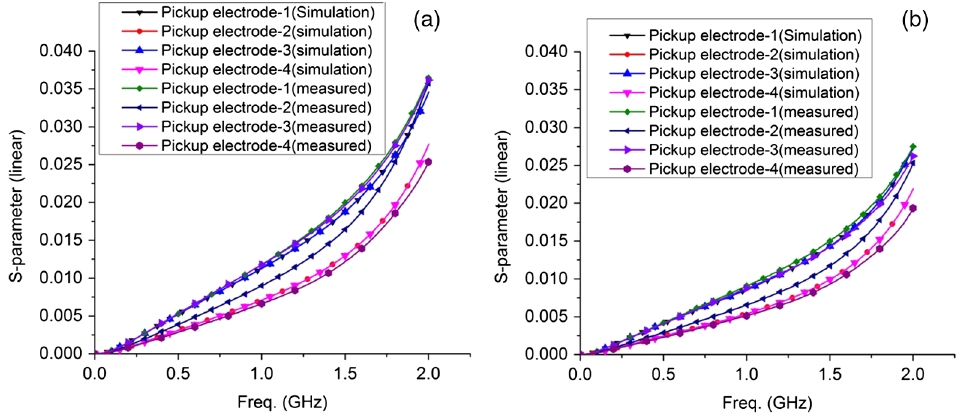
FIG. 17. Comparison of S-parameters of IDBPI obtained through simulation with measured data for different electrodes. (a) 1.5 mm wire diameter and (b) 0.6 mm wire diameter.